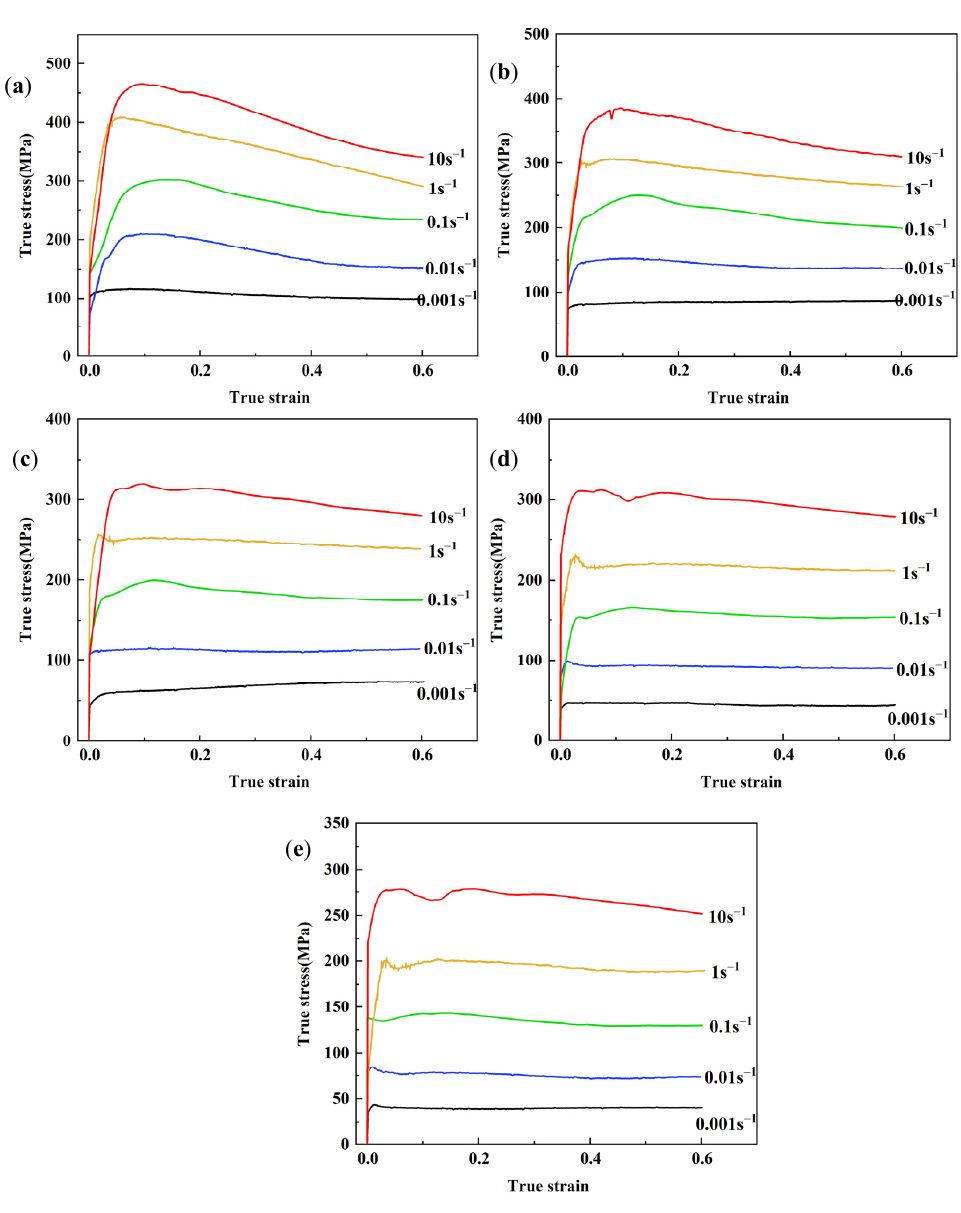
Figure 1. True-stress–true-strain curves during the deformation at different phase fields: ( a ) 700 ◦ C Figure 1. True ‐ stress–true ‐ strain curves during the deformation at different phase fields: ( a ) 700 °C ( α + β ), ( b ) 730 ◦ C ( α + β ), ( c ) 760 ◦ C ( α + β ), ( d ) 790 ◦ C ( β ), and ( e ) 820 ◦ C ( β ( α + β ), ( b ) 730 °C ( α + β ), ( c ) 760 °C ( α + β ), ( d ) 790 °C ( β ), and ( e ) 820 °C ( β ).